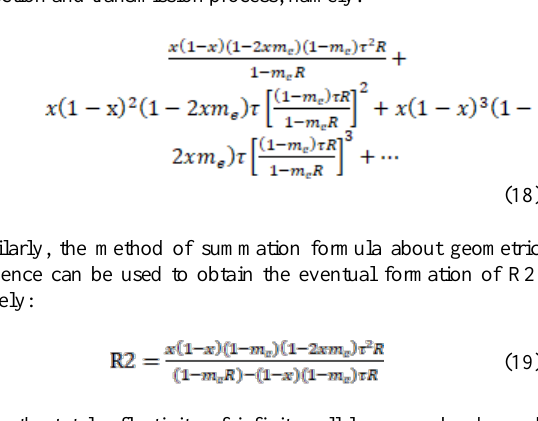
Figure 2. Interaction between monolayer cells and infinite layer